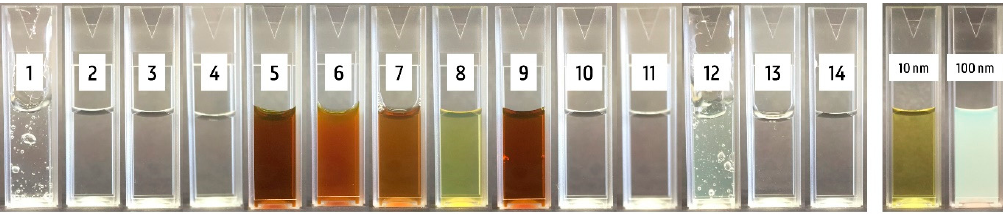
Figure 2. Visual analysis of the 14 different silver products and 10 and 100 nm silver nanoparticles (AgNPs) of Nanocomposix with a concentration of 20 mg L − 1 . Batch 1 is represented for products 5, 6, 8, and 9.